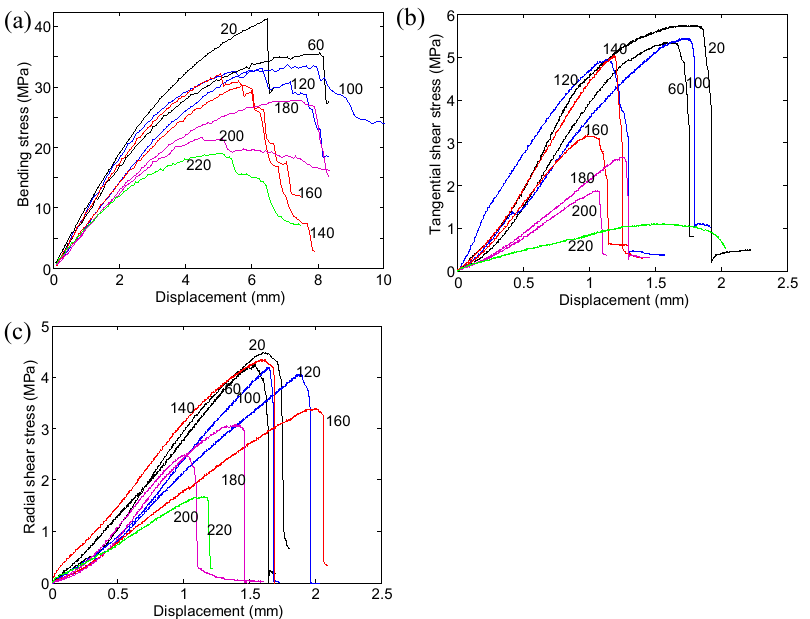
Figure 9. Typical stress–displacement curves: ( a ) three-point bending; ( b ) tangential shear; ( c ) radial shear.